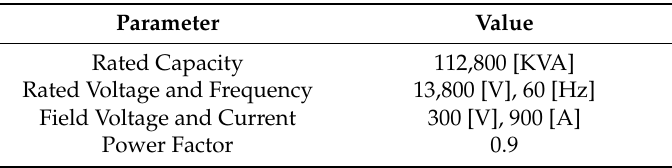
Table 1. The specifications of a gas turbine at thermal power plant.